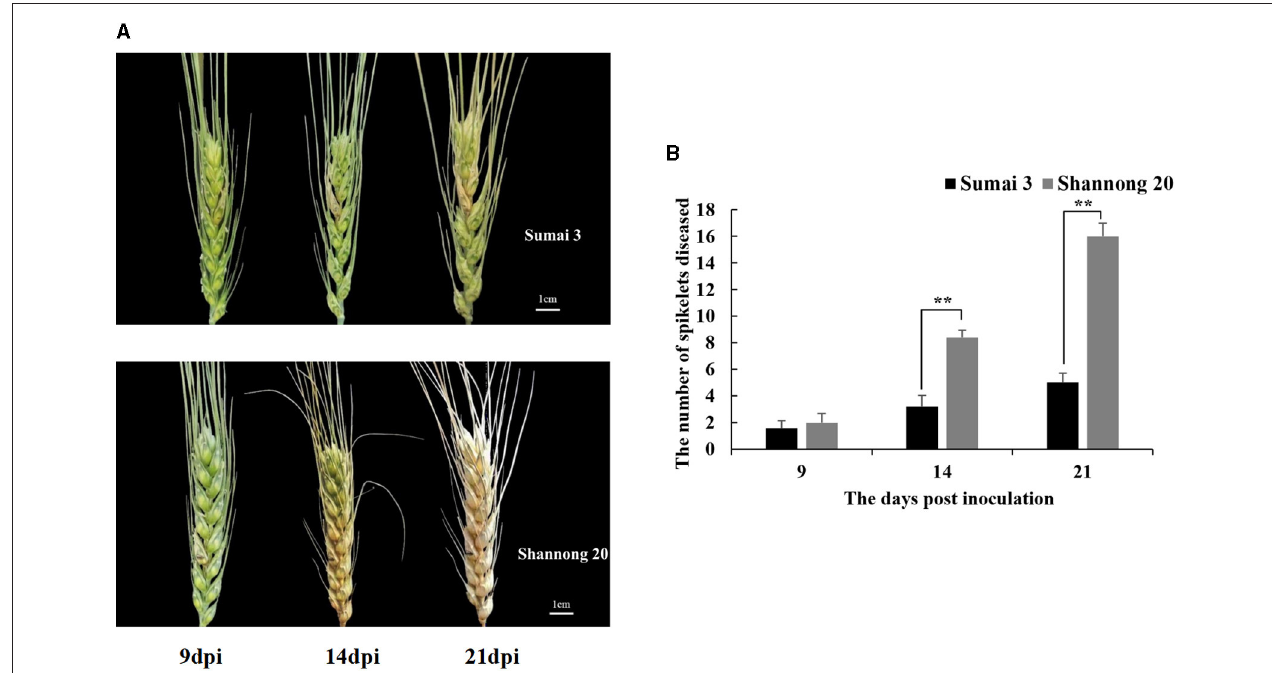
FIGURE 2 | (A) Fusarium head blight (FHB) symptoms at 9, 14, and 21 days post-inoculation (dpi) in wheat cultivars, Sumai 3 and Shannong 20, inoculated with F. graminearum . Shannong 20 is sensitive to FHB and high level of bleaching. (B) Number of diseased spikelets in Sumai 3 and Shannong 20. At 14 and 21 dpi, the number of diseased spikelets in Shannong 20 was significantly higher than that in Sumai 3 ( P value < 0.01). Student t -test P -value: ** P value <